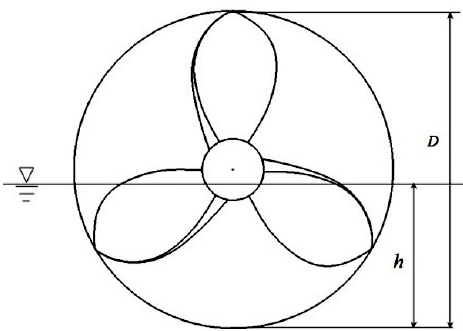
Figure 1. The submergence ratio of surface-piercing propellers (SPPs), which is defined as the ratio of the immersion depth h to the propeller diameter D .